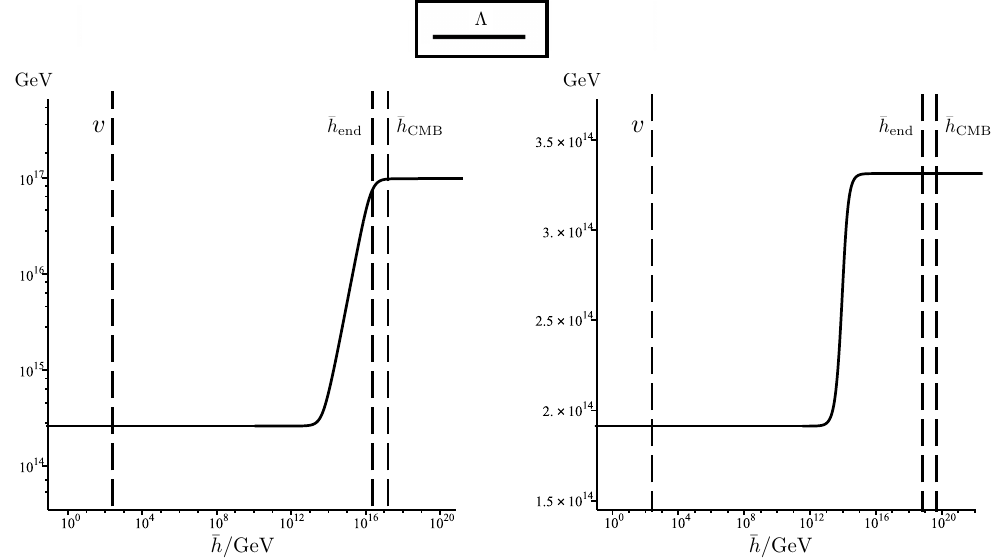
Figure 3 . The tree-level unitarity violation scale Λ as a function of the Jordan frame background field ¯ h in the metric formulation (left) and the Palatini formulation (right). The vertical lines mark the Higgs EW vacuum expectation value v , the end of inflation, and the CMB pivot